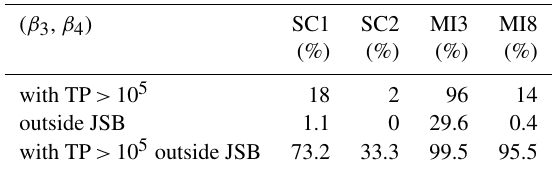
Table 2. Quantitative analysis of Fig.